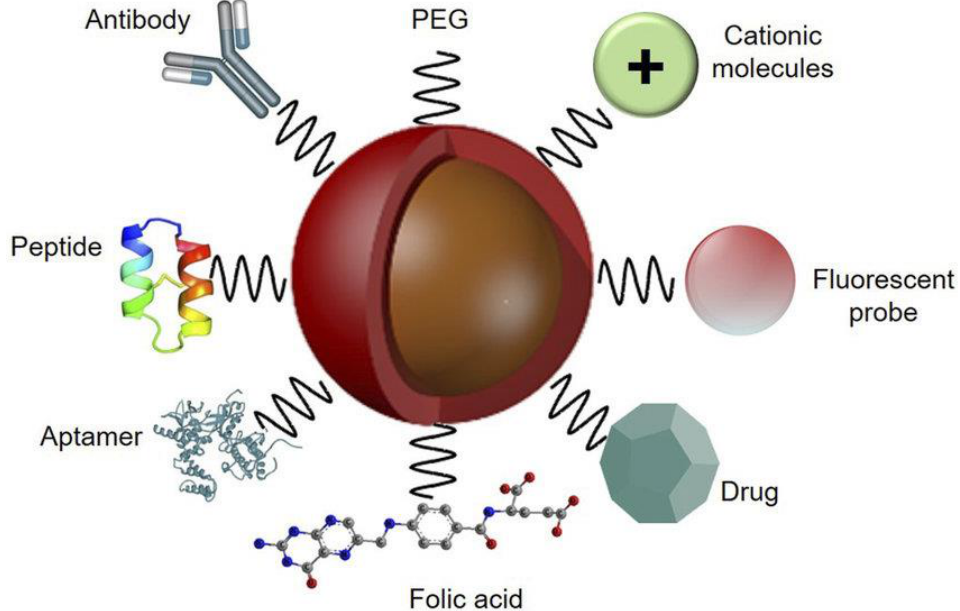
Figure 3. Representation of a nanoparticle functionalized with different types of ligands, polymers, therapeutic compounds, and biomolecules. Adapted from Ref. [40], copyright 2020, with permission from Impact Journals LLC.